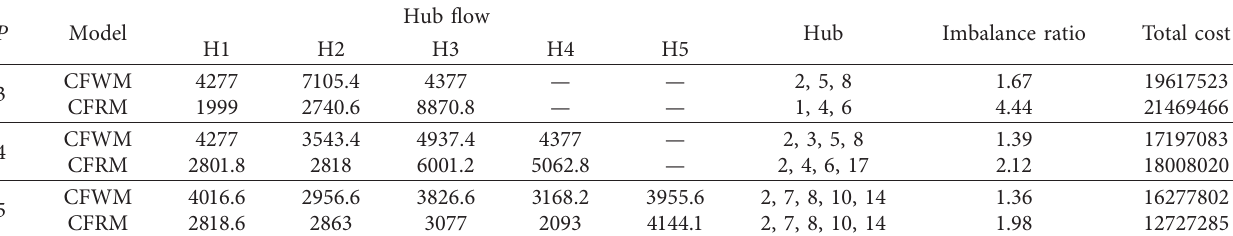
Table 5: Impact of hub number p on model results.